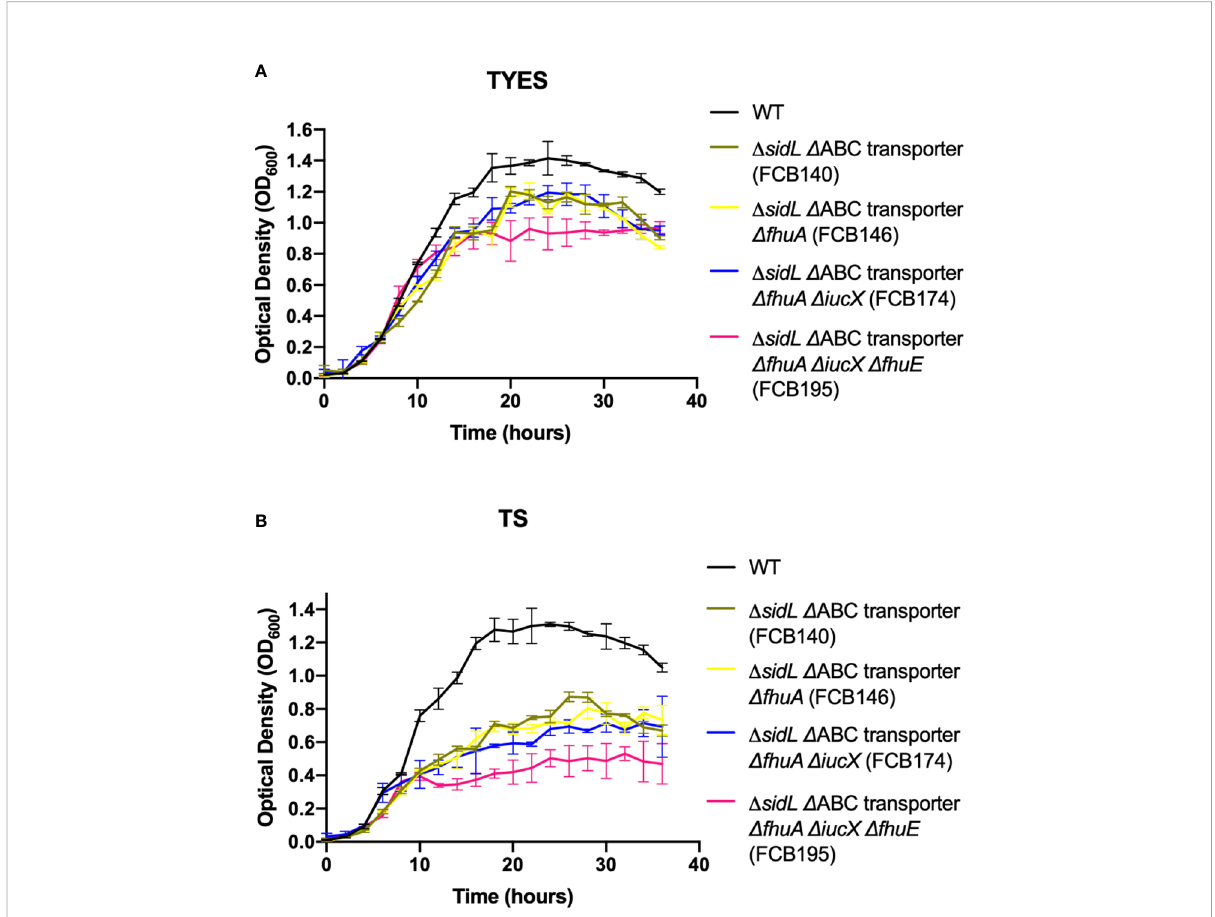
FIGURE 4 Growth of F. columnare wild type and mutants predicted to be de fi cient in multiple steps of iron uptake in iron-rich (TYES) and iron-limited (TS) medium. (A) Growth of wild type (WT), D sidL D ABC transporter mutant (FCB140), D sidL D ABC transporter D fhuA mutant (FCB146), D sidL D ABC transporter D fhuA D iucX mutant (FCB174), and D sidL D ABC transporter D fhuA D iucX D fhuE (FCB195) mutants in TYES. sidL is a roughly 14 kbp region containing genes involved in siderophore production, export, and regulation that was previously studied (Conrad et al., 2022). Signi fi cant differences in peak cell density were seen between the WT and FCB140, WT and FCB146, WT and FCB174 (P < 0.05), and WT and FCB195 (P < 0.0001). (B) Growth of the same strains described in panel ‘ A ’ in TS. Signi fi cant differences in peak cell density were seen between the WT and FCB140, WT and FCB146, WT and FCB174, and WT and FCB195 (P < 0.0001). Strains were grown at 28°C with shaking (200 rpm) and measurements were taken every two hours for 36 hours. Error bars represent standard error of the